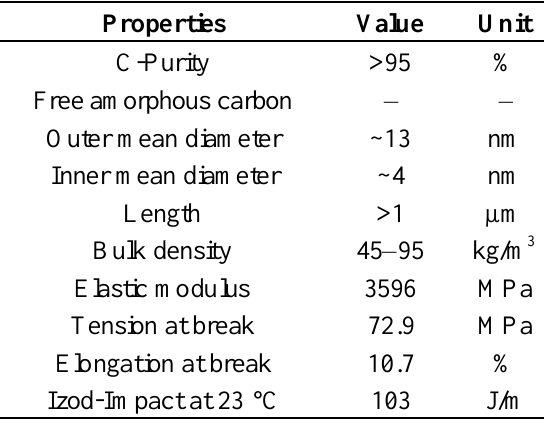
Table 1. Properties of Baytubes ® C 70 P Multiwall carbon nanotubes